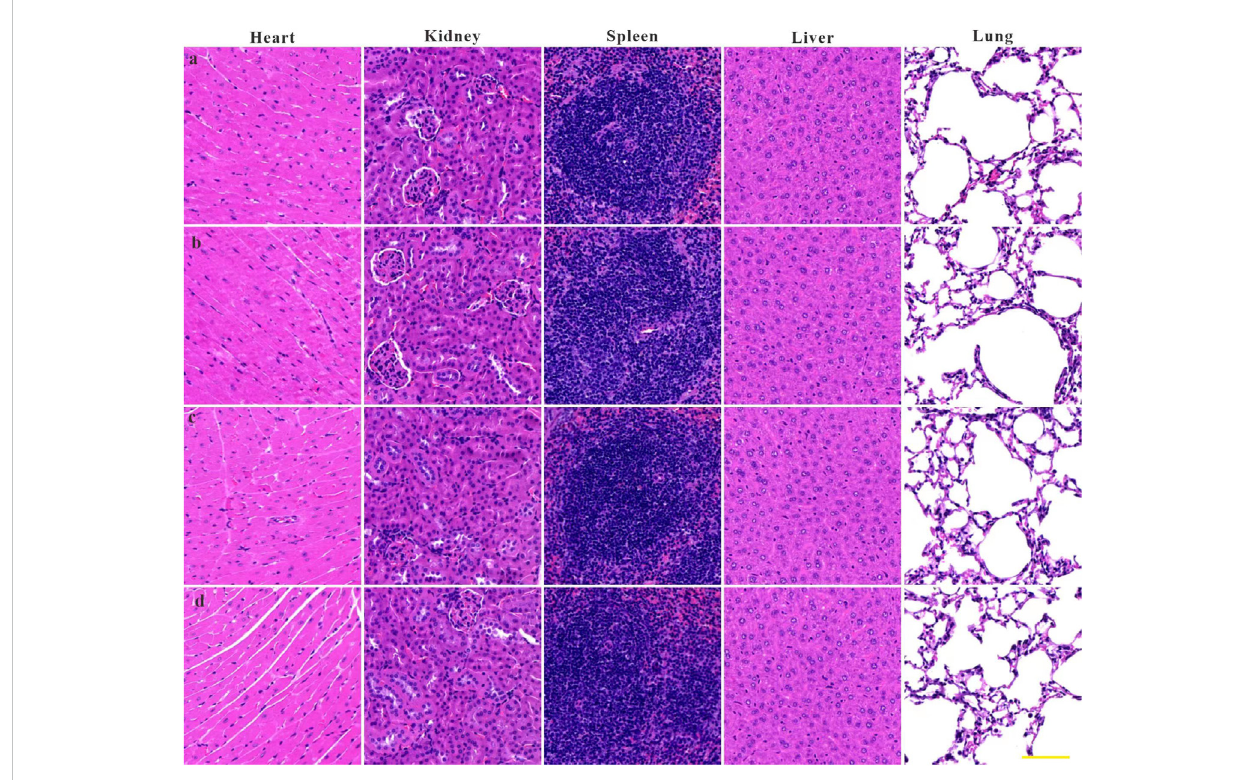
FIGURE 8 Histological evaluation of heart, liver, spleen, lung, and kidney samples from mice at 7 days upon administration of (A) PBS, (B) imipenem, (C) ZIF-8 and (D) Imi@ZIF-8. Scale bar is 100 μ